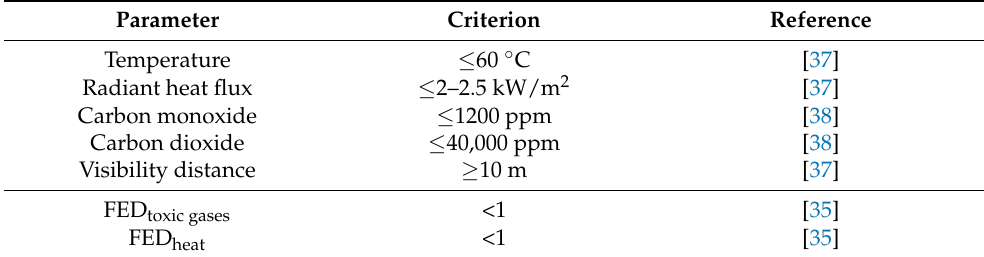
Table 4. Acceptable safety criteria for tunnel users in the event of a fire.